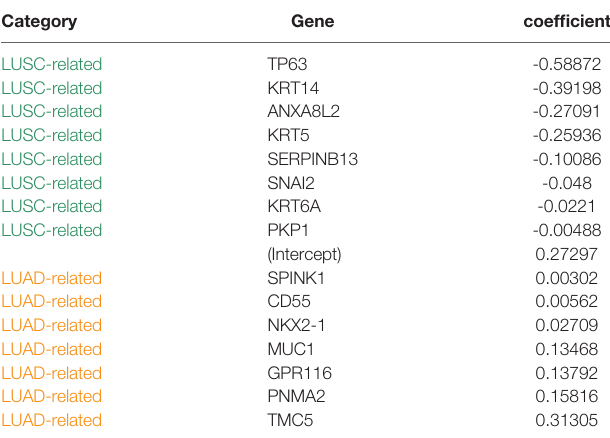
TABLE 2 | Genes and coef fi cients of the molecular subtyping